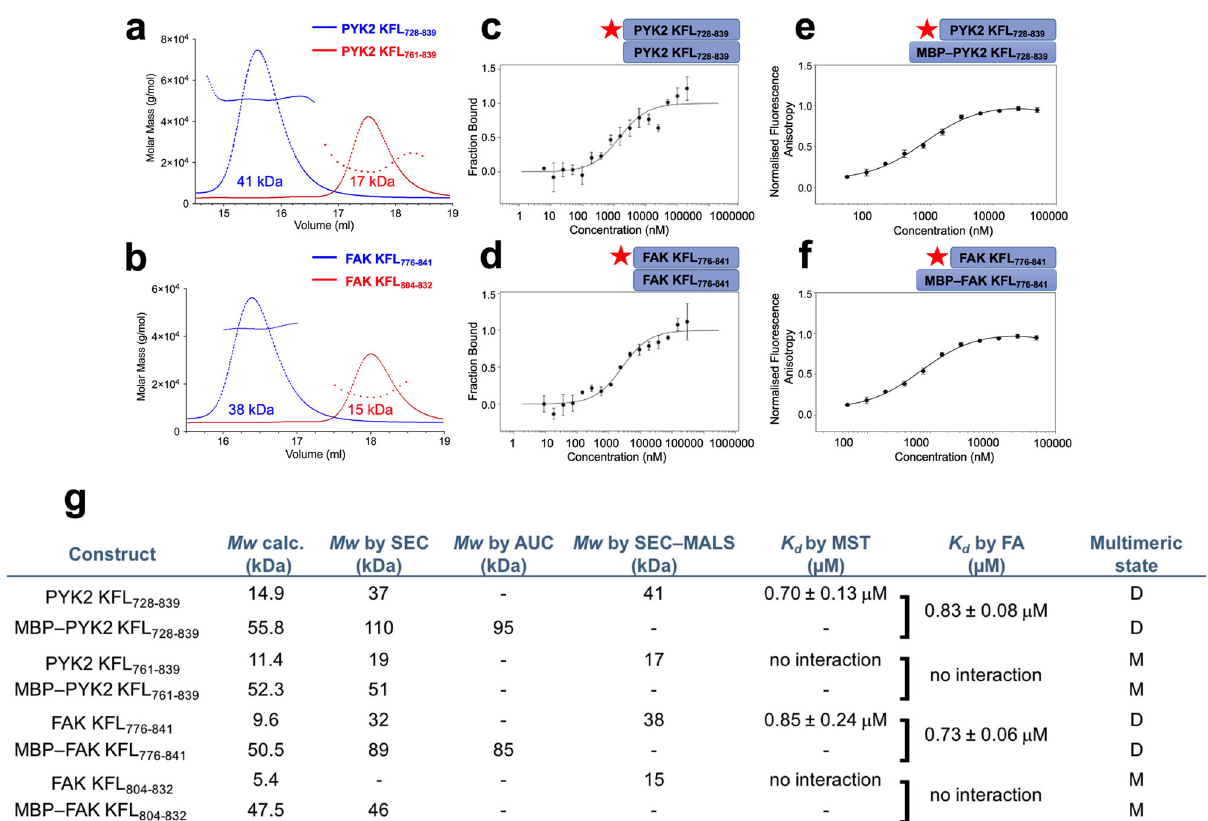
Fig. 3 PYK2 and FAK KFL dimerise. a , b SEC-MALS elution pro fi les on puri fi ed proteins. The Mw deduced for each peak is given. The additional lines show the molar mass distribution. c , d MST and e , f fl uorescence anisotropy (FA) studies. The red star indicates the fl uorescently labelled protein. MBP fusions were used to increase the Mw of the unlabelled molecule in FA. g Summary table, also including data derived from Supplementary Fig. 7a – f). The single square bracket indicates that the K d in FA was established between fl uorescently labelled protein and MBP-fused unlabelled protein. D: dimer; M: monomer. Binding experiments are represented as (mean ± SD, n =